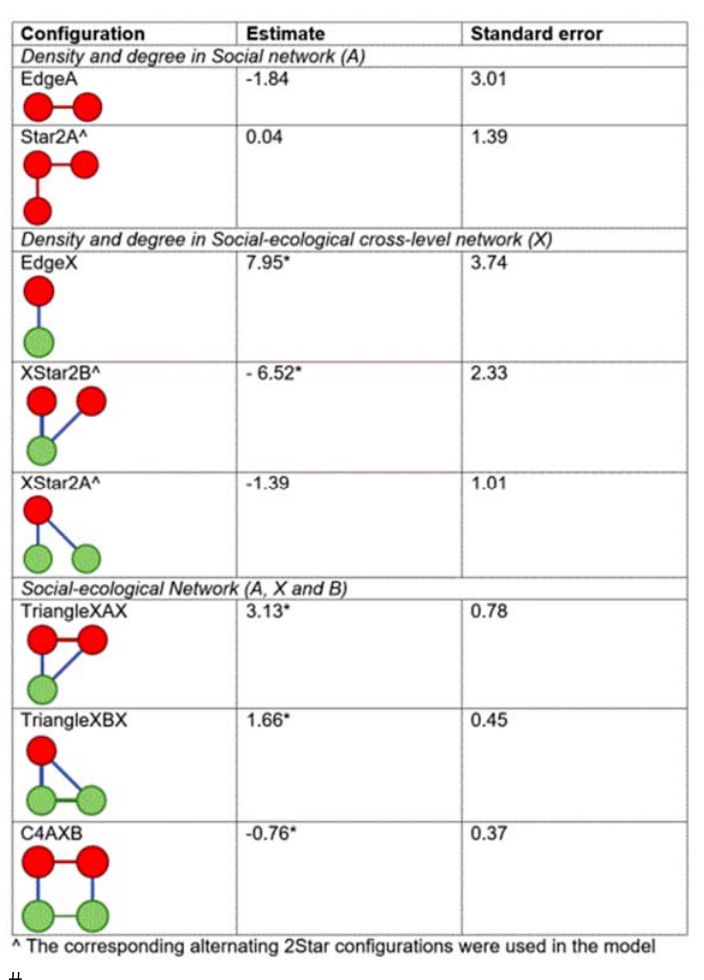
Figure A1.2. A fitted ERGM (from Fig. A1.1) including centralization parameters (prefixed